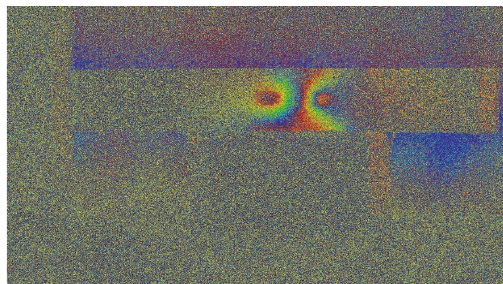
Figure 6: Shearography image of the failed